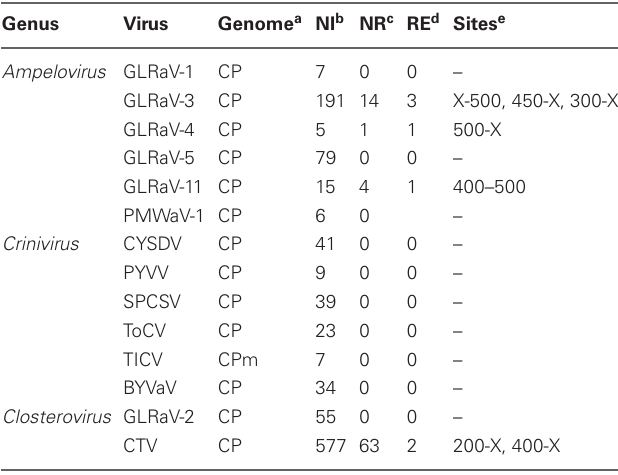
Table 2 | Recombination events detected in the coat protein genes of viruses of the family